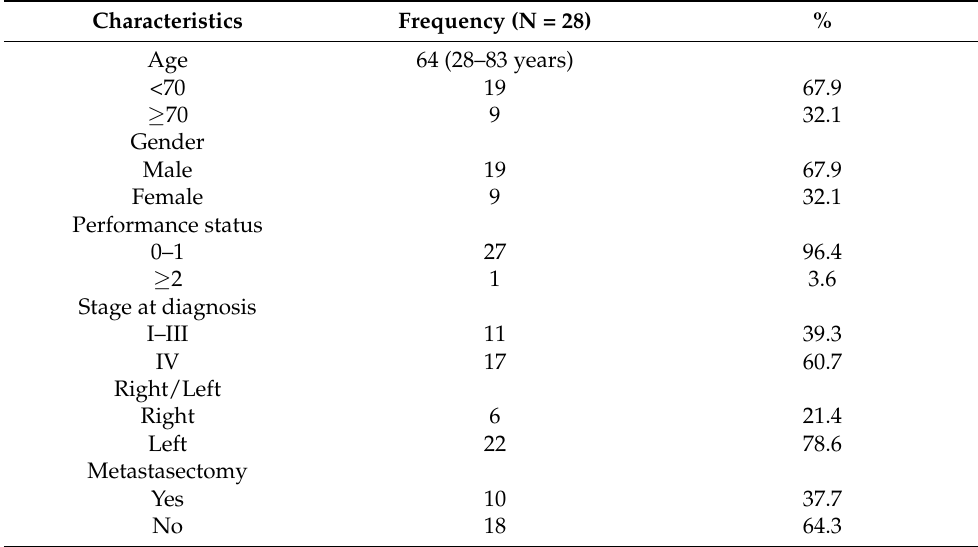
Table 3. Demographics of KRAS -G12C-mutated patients.